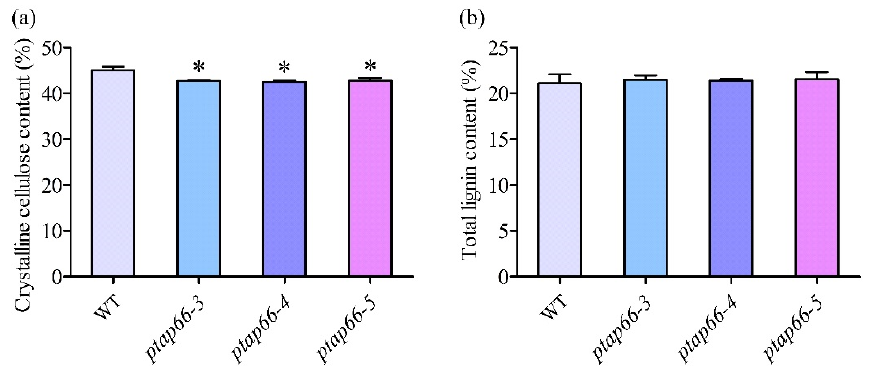
Figure 6. Analysis of crystalline cellulose and total lignin contents in dry wood of WT plants and ptap66 mutants. Starch-free wood was used to measure crystalline cellulose ( a ) and total lignin ( b ) contents. Error bars represent ± SD values of three biological repeats. Asterisks indicate significant differences between each line of ptap66 mutants and WT plants by Student’s t -test (* p < 0.05).